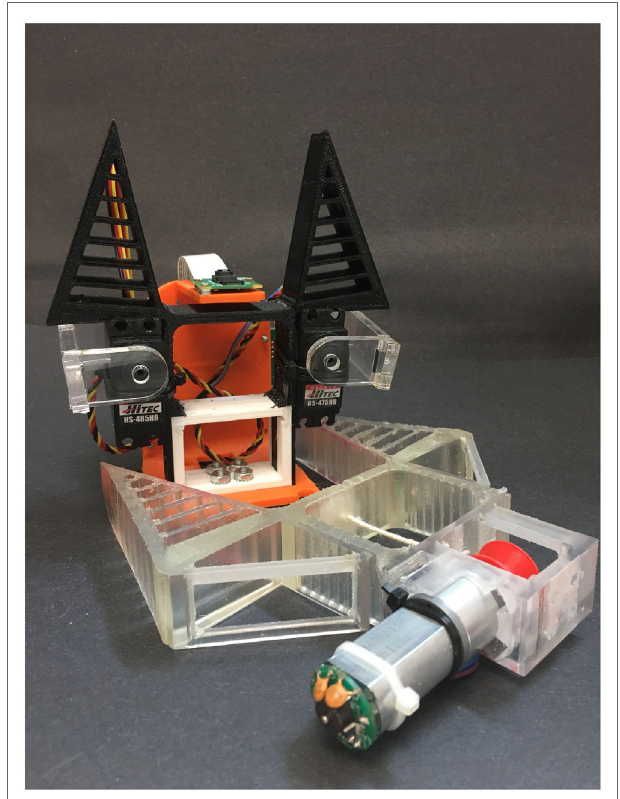
FigUre 7 | The ninjaFlex/Pla Tihra gripper equipped with a raspberryPi and an attachment for the Baxter arm is shown next to the TangoPlus/Veroclear gripper used in the testing and the robosoft grand challenge